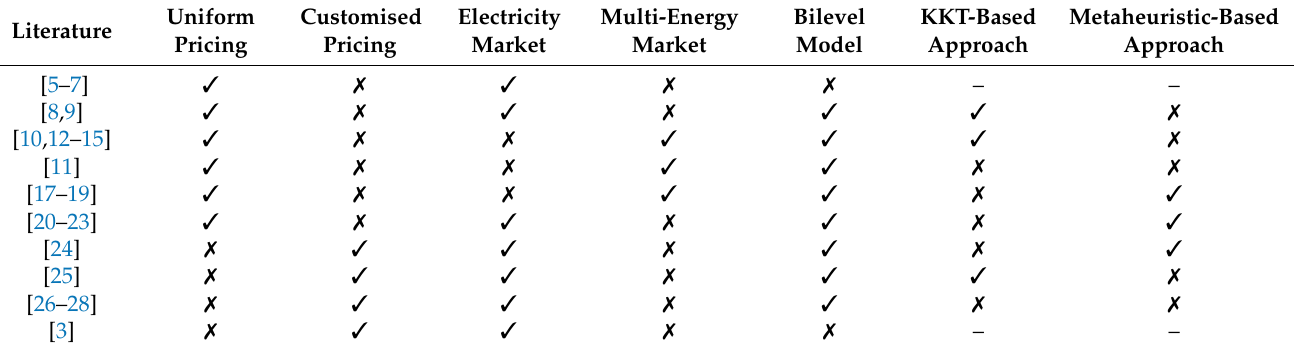
Table 1. Literature comparison. (cid:51) : Yes; (cid:55) : No; –: Not